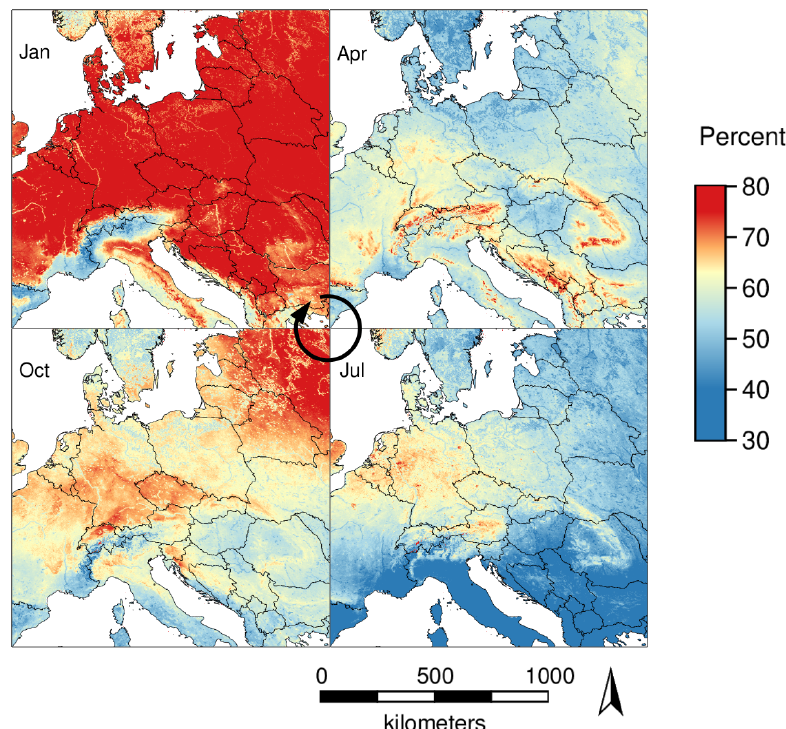
Figure 2. Spatial distribution of the percentage of missing LST pixel values aggregated over the years 2003 to 2016 for the months January, April, July, and October.